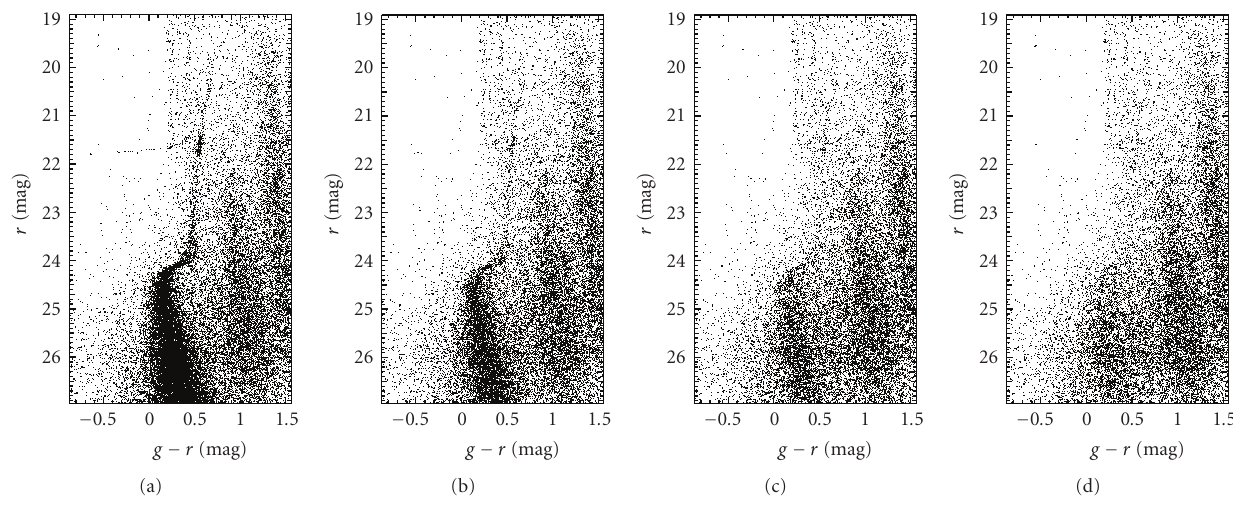
Figure 3: A series of four ( g − r , r ) mock colour-magnitude diagrams of a 10 Gyr old, [Fe / H] = − 2 . 0 single burst stellar population (Padua library) at 150 kpc with realistic Galactic foreground (TRILEGAL; [64]), background galaxies (ACS; [65]) and photometric errors as expected from observations at an 8-m class telescope. Each stellar population has its total luminosity decreased by one magnitude from left to right. The top of the main sequence and the MSTO remain the only visible features that reveal the presence of an ultrafaint dwarf.